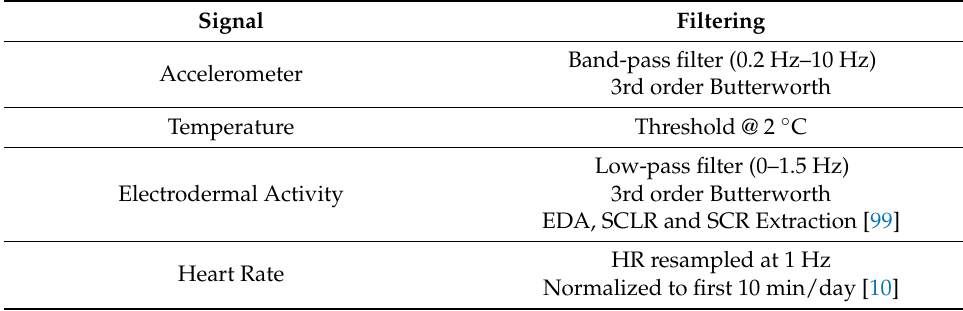
Table 6. Signal preprocessing.